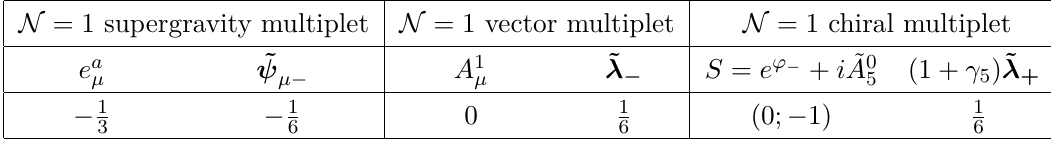
Table 3 . N = 1 , D = 4 field